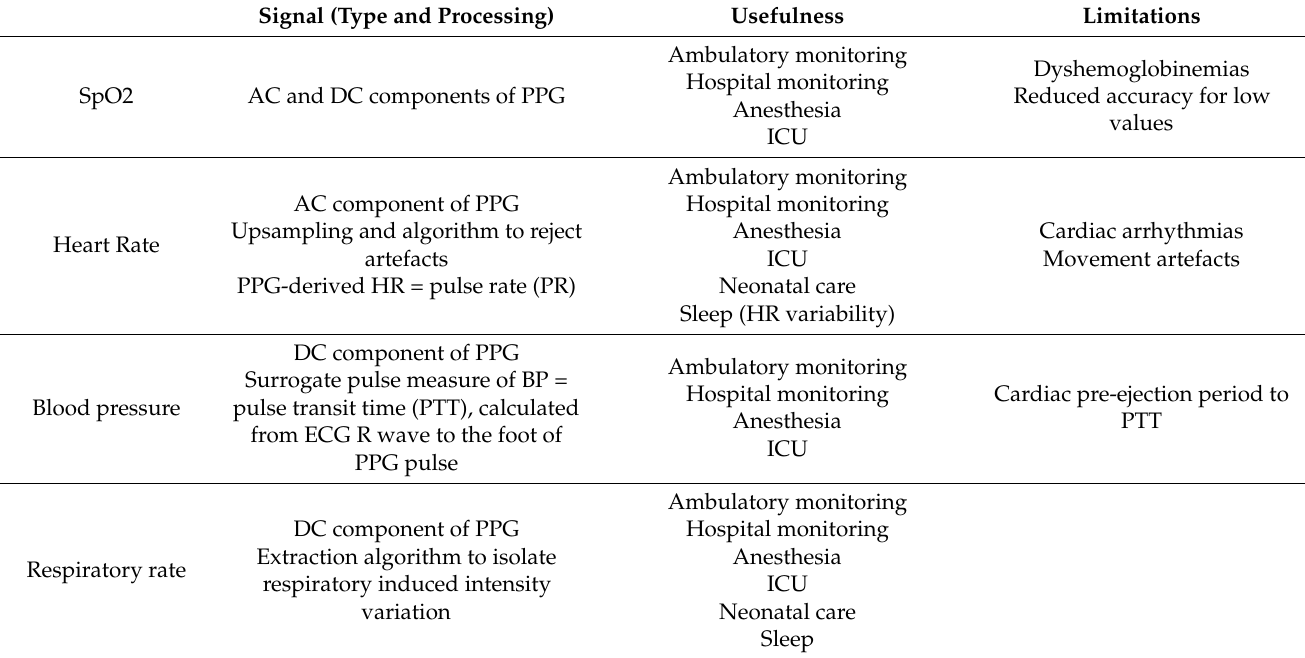
Table 1. Applications of photoplethysmography in clinical physiological measurements in healthy subjects. Signal (Type and Processing)